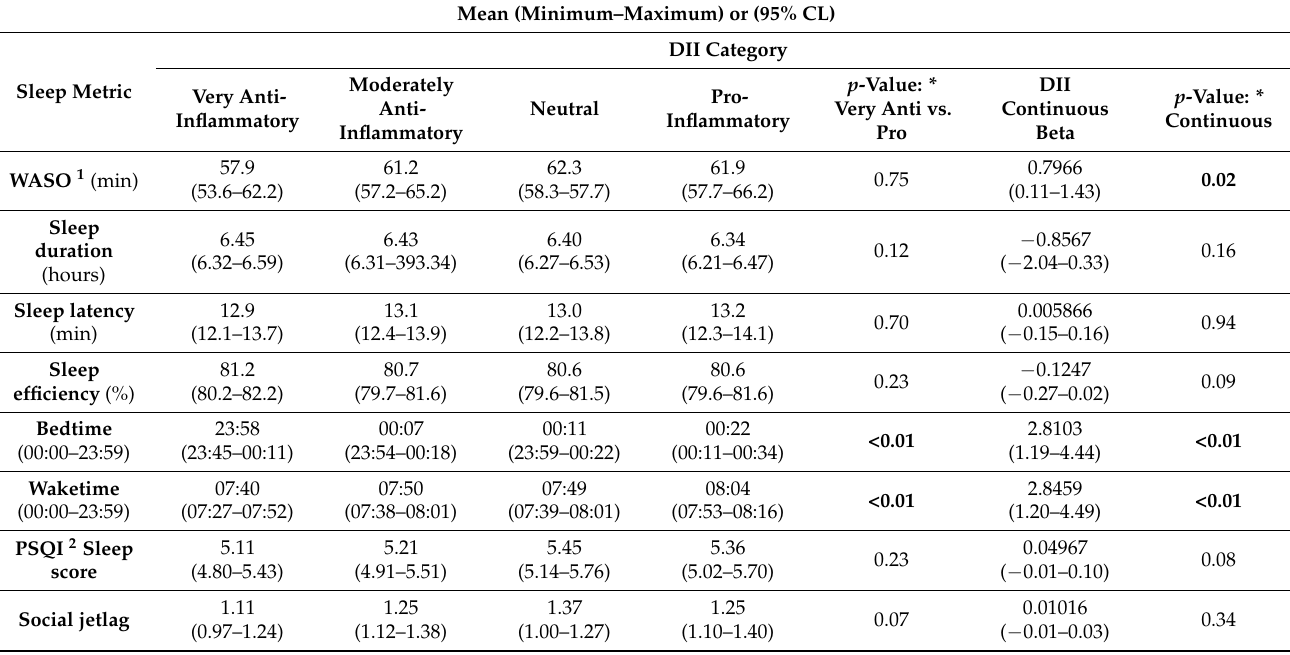
Table 2. Sleep metrics and dietary inflammatory indices per participant.